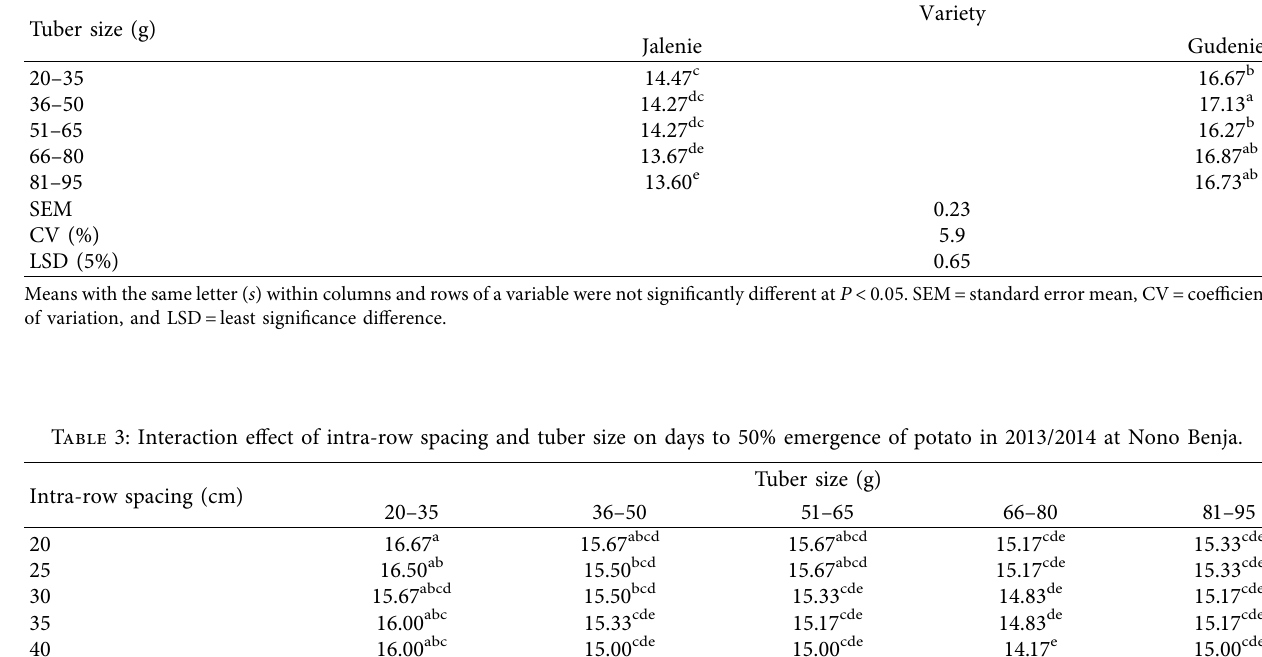
Table 2: Interaction effect of variety and tuber size on days to 50% emergence of potato in 2013/2014 at Nono Benja. Tuber size